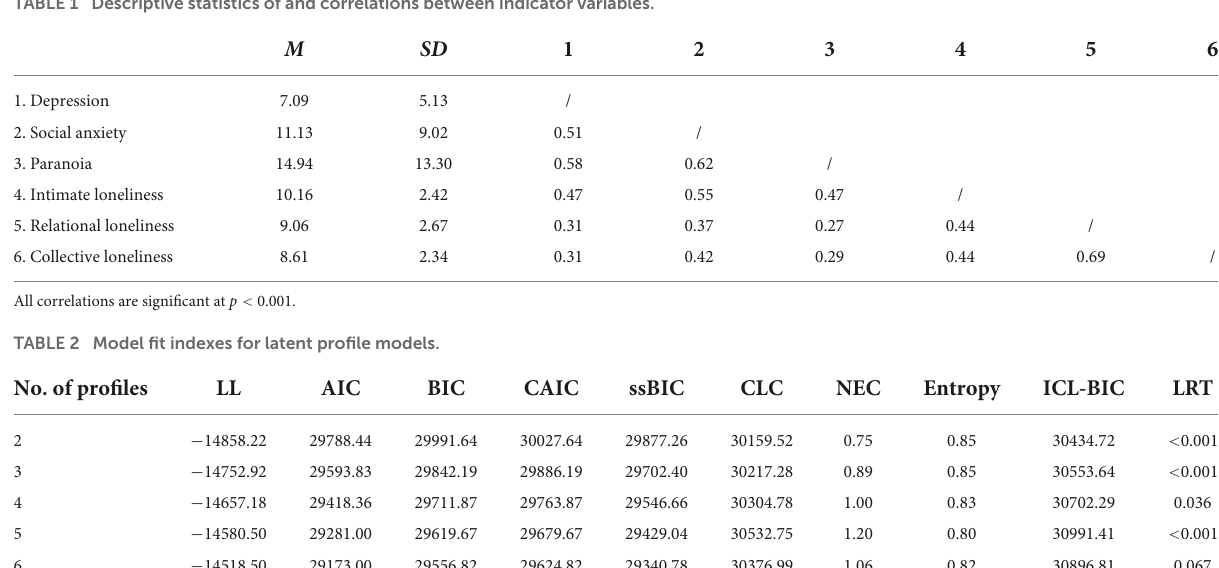
TABLE 1 Descriptive statistics of and correlations between indicator variables.